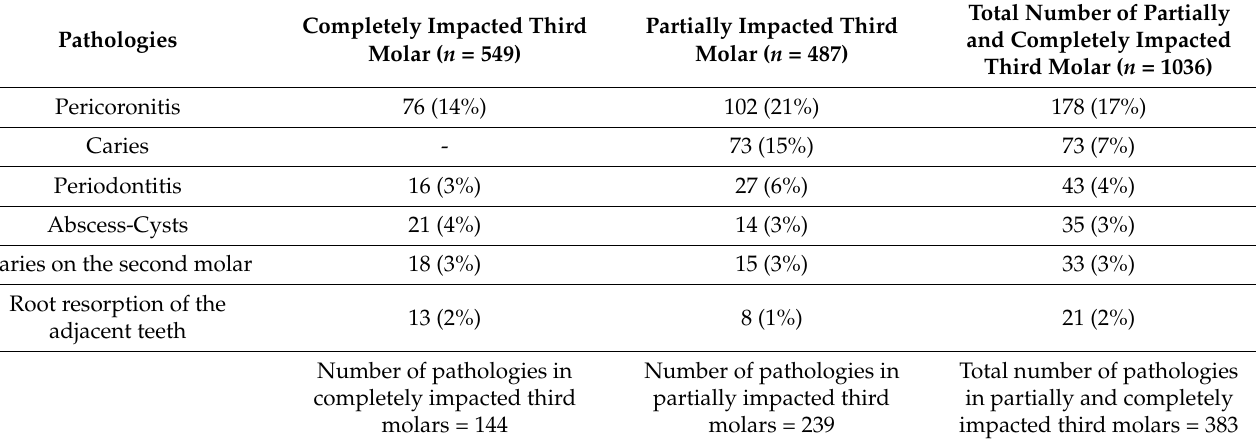
Table 5. Distribution of pathologies associated with partially and completely impacted third molars.